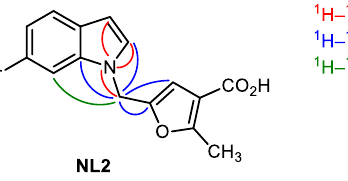
Figure 7. Two-dimensional NMR assignments of the structures.